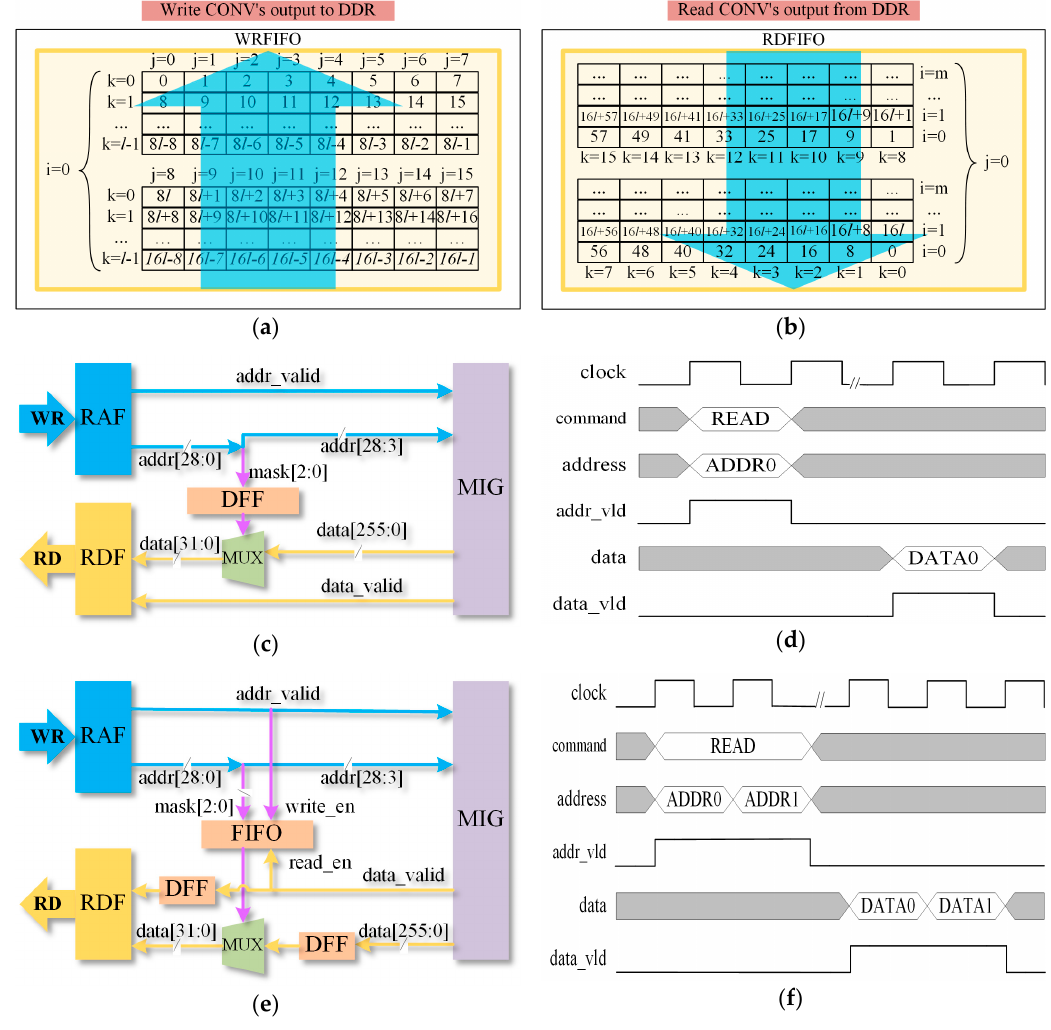
Figure 9. Memory access module design and optimization. ( a ) Write CONV ʹ s output to DDR. ( b ) Read